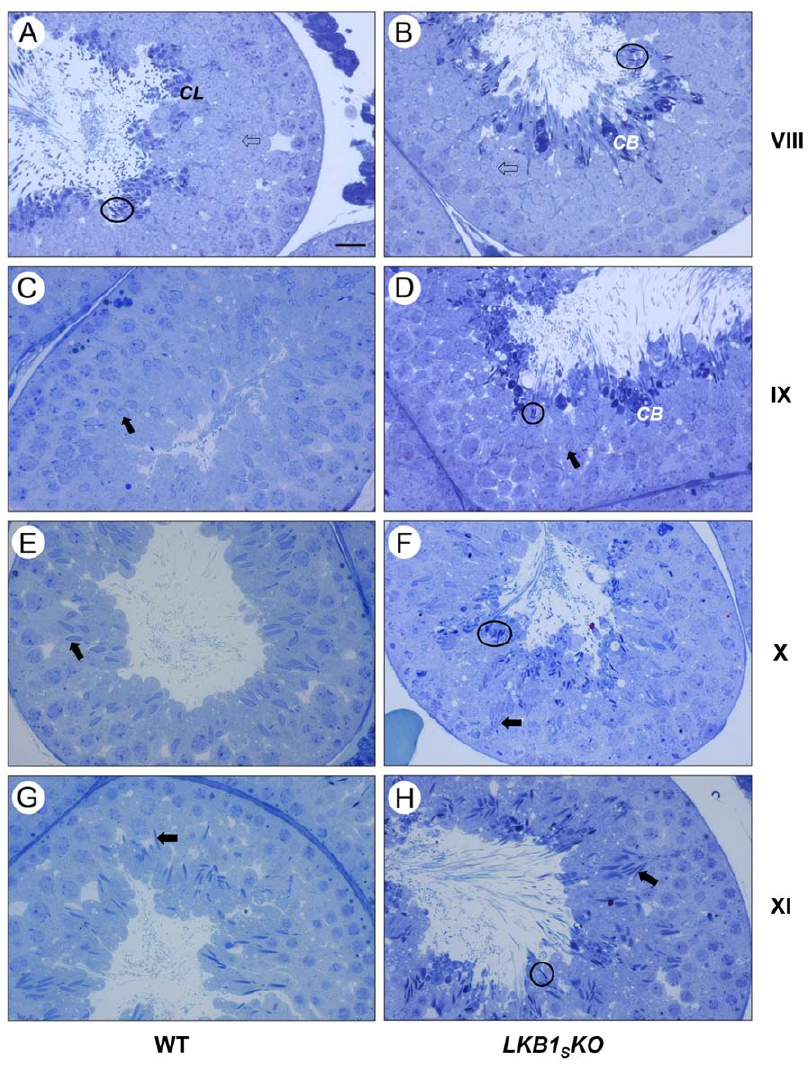
Figure 5. LM images showing ‘failure of spermiation’ in LKB1 S KO mice. Representative images of seminiferous tubules are shown at stage VIII ( A,B ), when spermiation normally occurs; and stages IX, X, and XI ( C – H ), after spermiation has normally taken place. The stage numbers are shown to the right of the images. Elongated spermatids are identifiable by their darkly-staining, condensed nuclei. The nuclei of immature round spermatids ( open arrows ) and elongating spermatids ( closed arrows ) are less deeply stained and can be seen embedded within the epithelium at the relevant stages of both WT and LKB1 S KO sections. There is a progressive condensation and elongation of the nucleus of the elongating spermatids from stage IX to stage XI. Sections from wild-type mice are displayed on the left. At stage VIII, elongated spermatids ( examples circled ) and cytoplasmic lobes (CL) are visible around the lumen. There are no elongated spermatids present around the lumen after stage VIII in wild-type sections. In contrast, in tubules from LKB1 S KO mice, shown on the right, elongated spermatids are visible around the lumen at all stages displayed ( examples circled ). In addition, abnormal deeply staining cytoplasmic bodies (CB) can be seen around the lumen, (scale bar =20 m m).